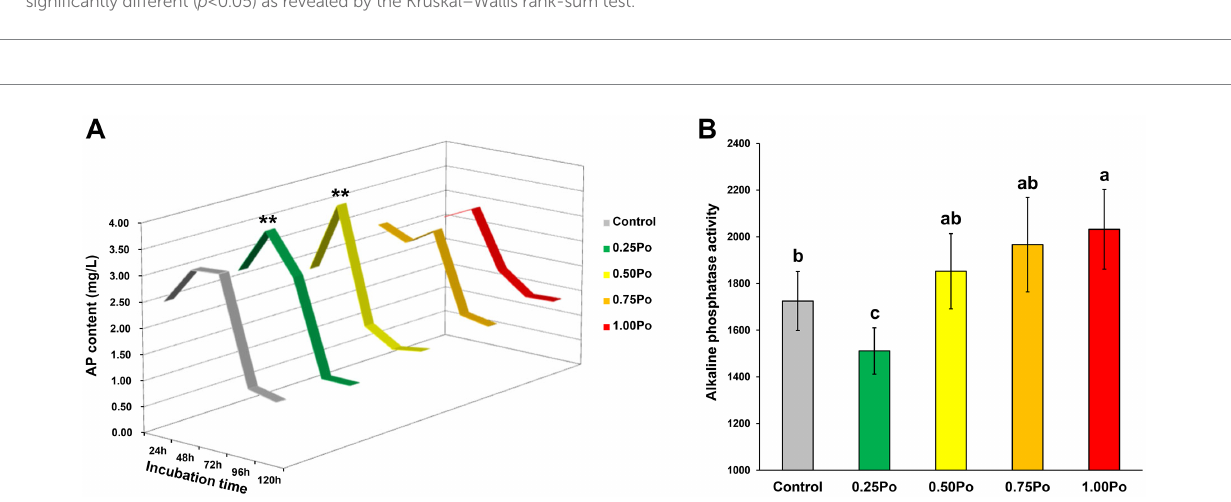
FIGURE 3 Dynamics of inorganic P solubilization by microbes (A) and changes in soil alkaline phosphatase activity (B) under different treatments. **Indicates a significant difference compared with the control. Bars with different letters (shown above each) are significantly different ( p < 0.05) as revealed by the Kruskal–Wallis rank-sum